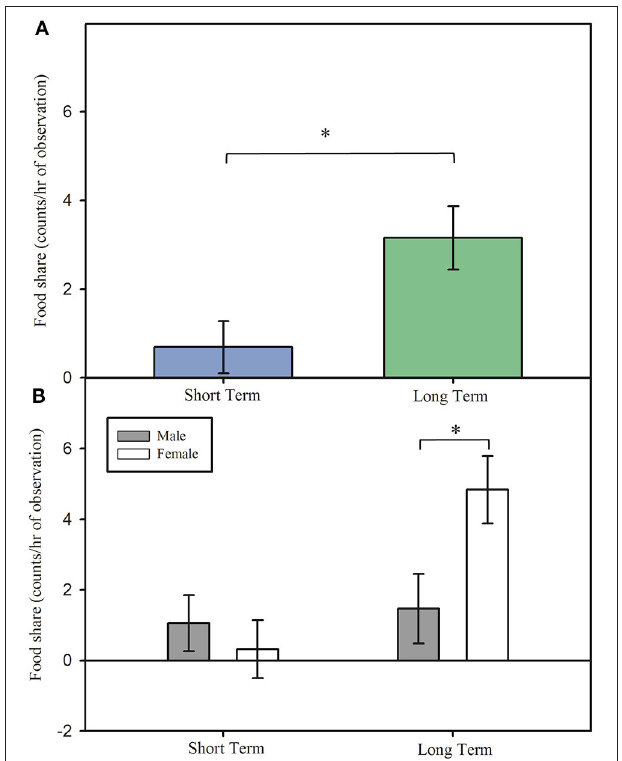
FIGURE 2 | Food sharing (model estimates ± SEM) among short and long term marmoset pairs. (A) Long term marmoset pairs engaged in more food sharing during reunion than did short term marmoset pairs. (B) Females in long term pairs engaged in more food sharing during reunion than did males in long term pairs. There was no significant difference in food sharing between males and females in short term pairs. *Indicates significant difference at p < 0.05.